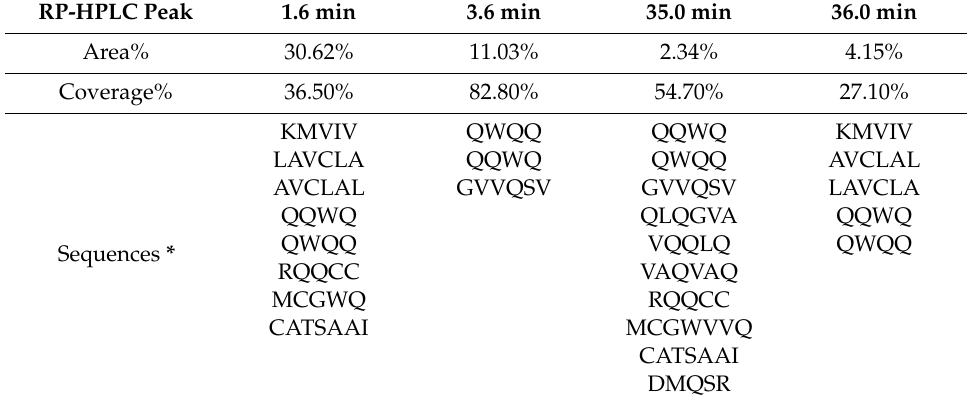
Table 1. Representative antioxidant peptides in kafirin Alcalase